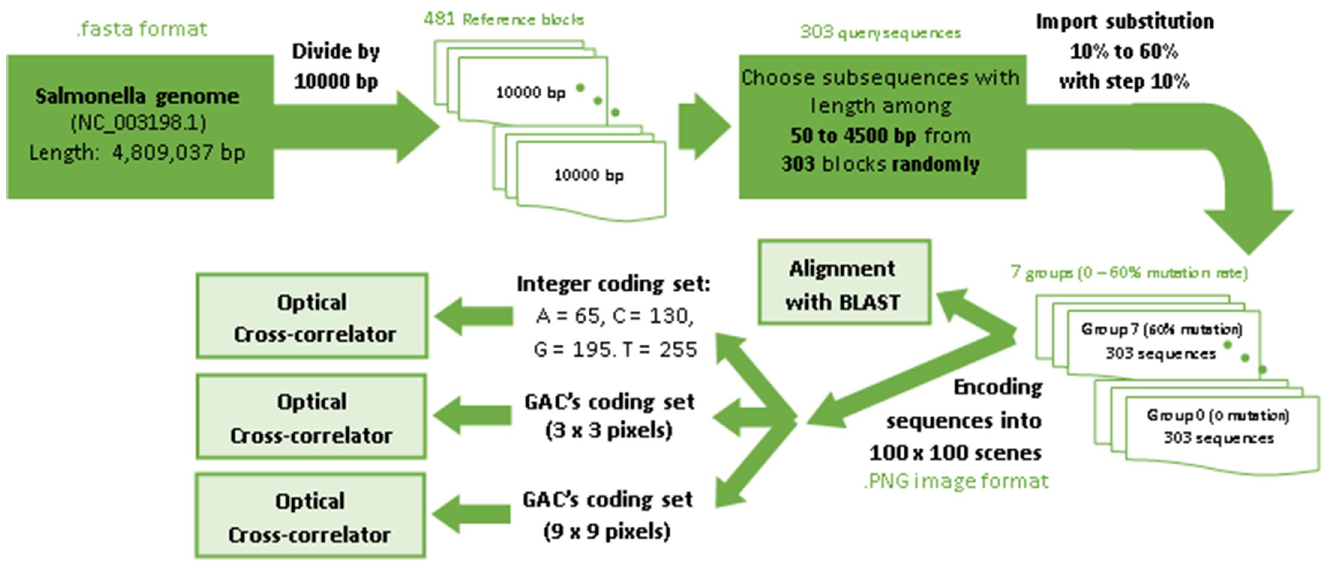
Fig 9. Evalution